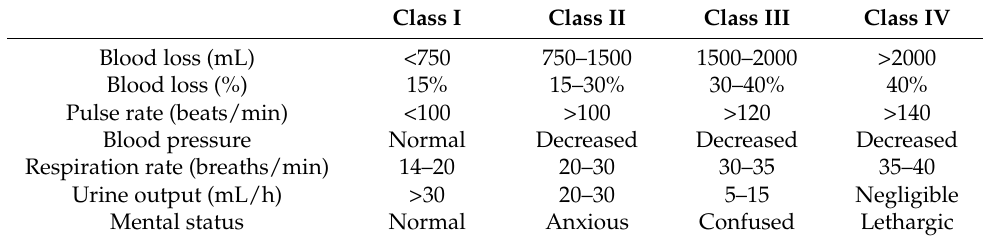
Table 1. Hemorrhagic shock classification